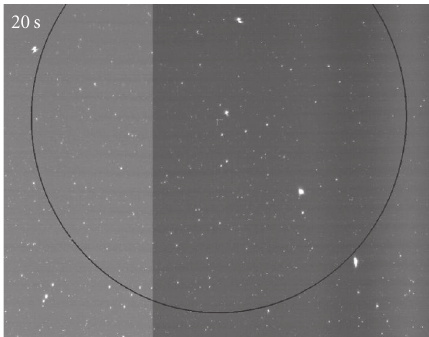
Figure 20: MASTER-VWF4 Kislovodsk GRB090320B follow-up observation. This is a 40 ◦ × 24 ◦ full-frame image. The black circle shows the error box corresponding to the 3 sigma FERMI error limits plus the 3 ◦ systematic error ( R = 12 . 6 ◦ ) [13]. Animation is available here http://observ.pereplet.ru/images/GRB090320B/ GRB090320B 60sec.gif.